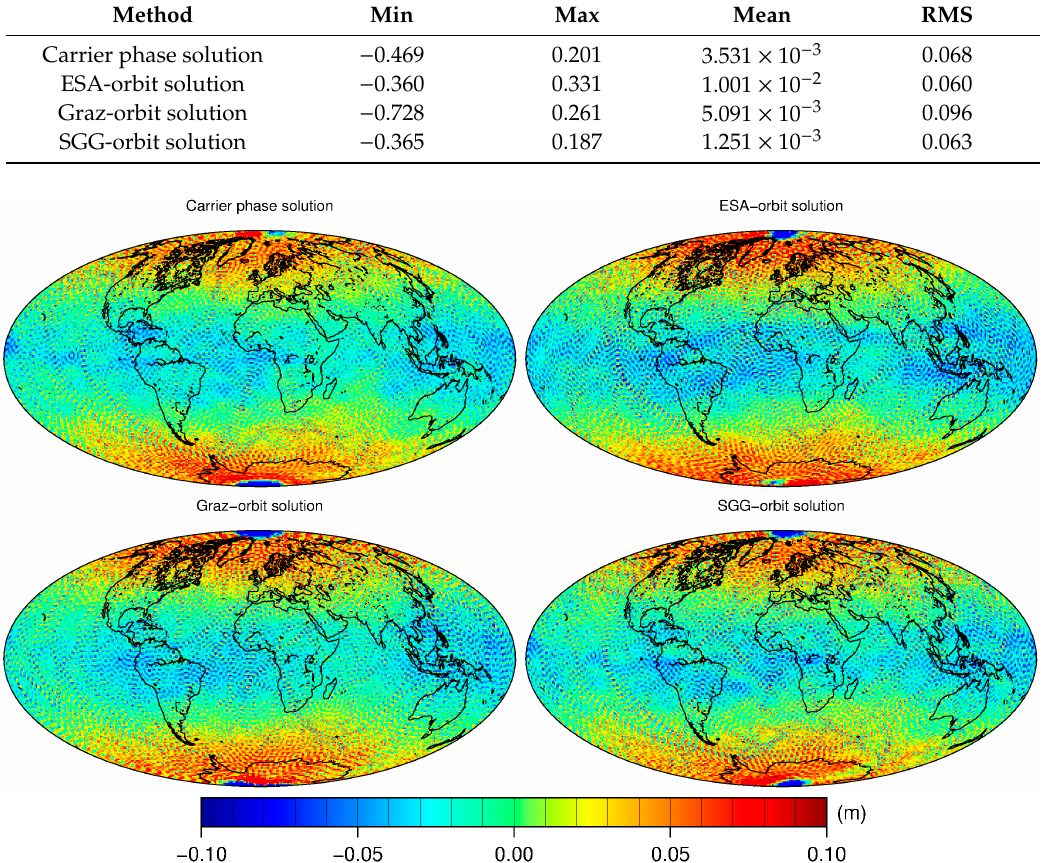
Table 6. Statistics of the geoid height di ff erences (unit: m) w.r.t. EIGEN-6C4 with the 500 km Gaussian smoothing applied.